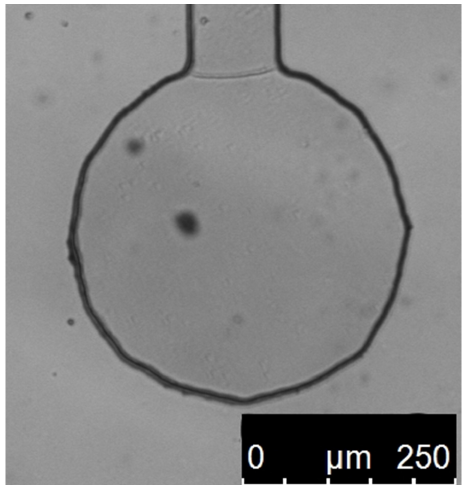
Figure 4. Picture of the experimental chamber, with one inlet, filled with pure water, in which the measurements on single particles were made. The inlet is at the top. It is part of a bigger microchannel chip made from PDMS, each chip containing around a dozen of such wells, each connected to one big channel (above the inlet, not shown here). Dark spots on the image are from dust on the optics and camera sensor.